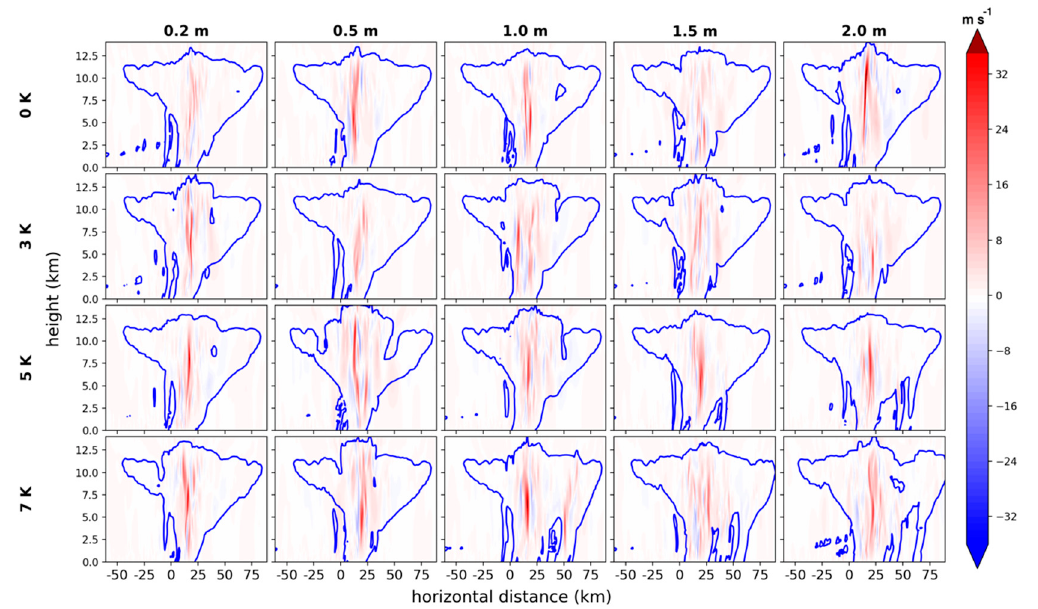
Figure 6. Same as Figure 5, except at 170 min.